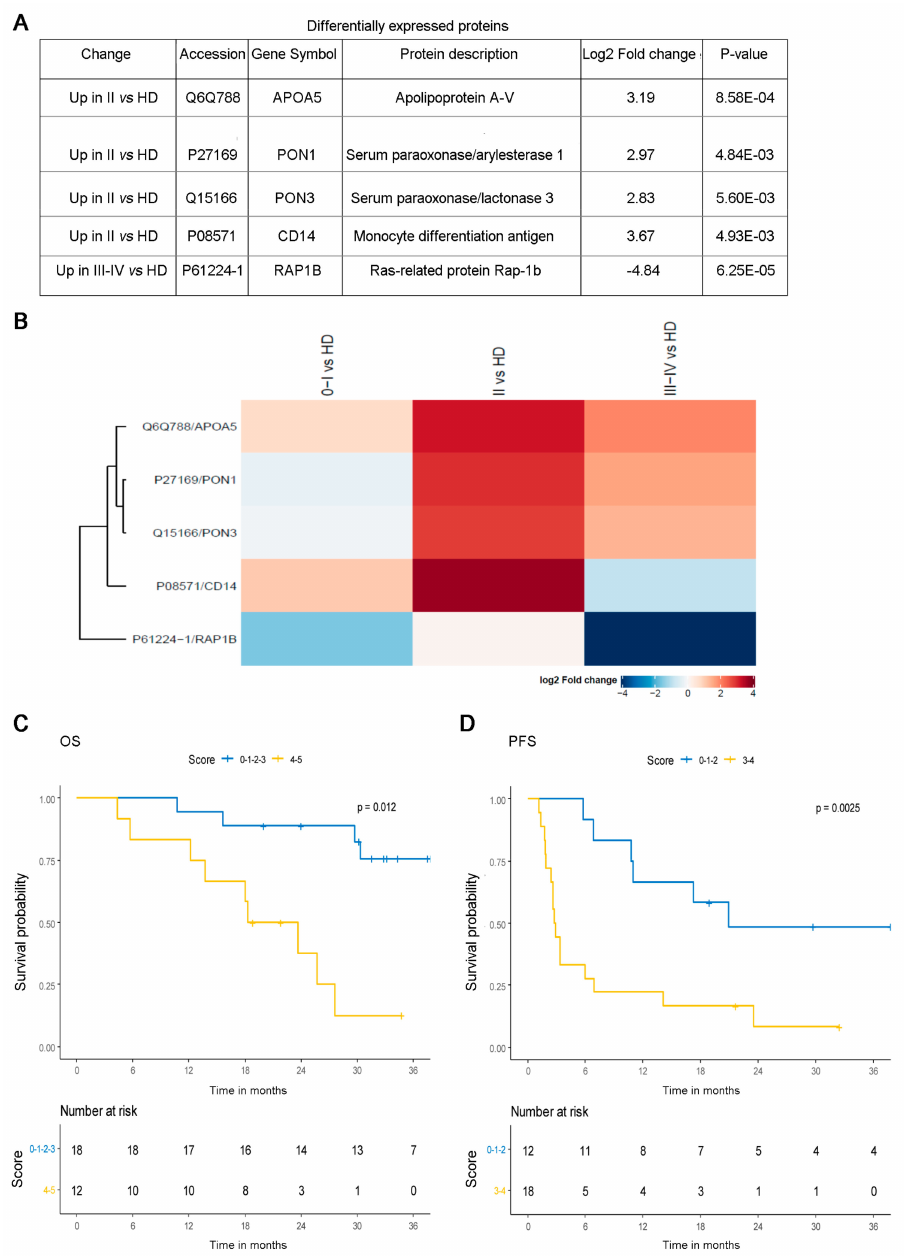
Figure 4. Analysis of differentially expressed proteins in CD81sEV. ( A ) Table of proteins found as statistically differentially expressed in CD81sEV from HD versus patients. ( B ) Protein fold changes in the different stages. The proteins APOA5 (Q6Q788), PON1 (P27169), PON3 (Q15166) and CD14 (P08571) were increased in stage II in comparison with HD; RAP1B (P61224-1) was decreased in stage III–IV versus HD. C,D. Overall survival (OS) ( C ) and progression-free survival (PFS) ( D ) of metastatic melanoma patients (baseline levels of transcripts detected by RNA-seq in plasma EV from Shi et al. [55], validation dataset, n = 30), based on the expression levels of the 5 genes assessed by multivariable score approach. Patients with low scores ( ≤ 3 or >3 altered genes for OS and ≤ 2 or >2 altered genes for PFS) had significantly better prognoses. Kaplan–Meier survival curves with log-rank P values are